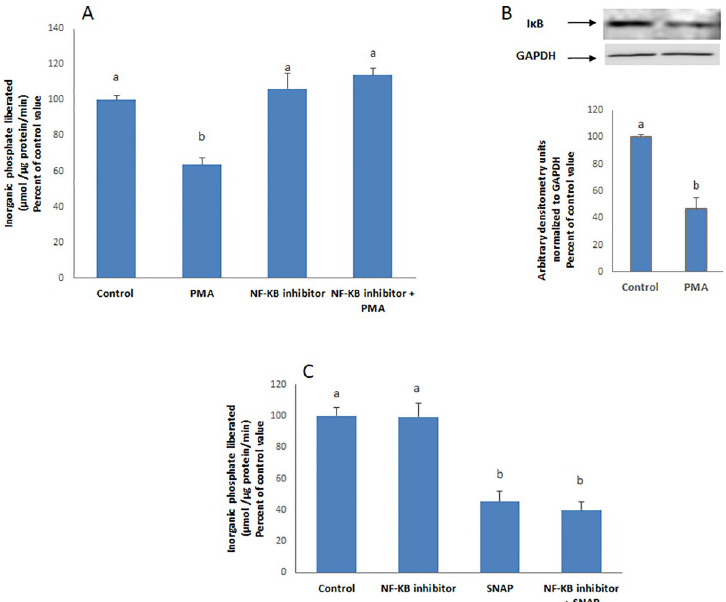
Fig 5. PKC activates NF- κ B. (A) PMA (100 nM) could not inhibit the ATPase in cells pre-treated with an inhibitor of NF- κ B (15 μ M, 30 min) and (B) decreased significantly the protein expression of I κ B. The effect of ( C) SNAP (2 μ M, 20 min) was not affected by the inhibitor. Values are means ± SEM of at least 3 observations. Bars not sharing a common letter are considered significantly different from each other at P < 0.01.